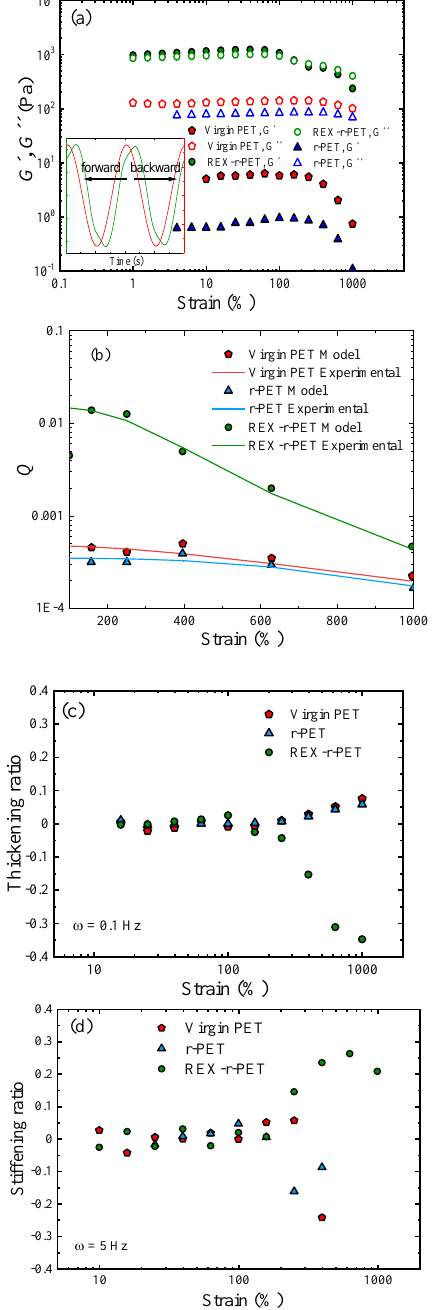
Figure 11. Results for the LAOS nonlinear oscillatory test. ( a ) Evolution of the storage modulus, G 1 (cid:48) and G 1 (cid:48)(cid:48) , as a function of the strain obtained at a constant frequency of 0.1 Hz. We focus on the stress curve, which corresponds to 200% of the applied strain for virgin PET and REX-r-PET. ( b ) The intrinsic nonlinearity Q 0 of three investigated samples obtained in the MAOS regime. ( c ) Evolution of the shear-thickening ratio with strain at 0.1 Hz. ( d ) Evolution of the shear-stiffening ratio with strain at 5